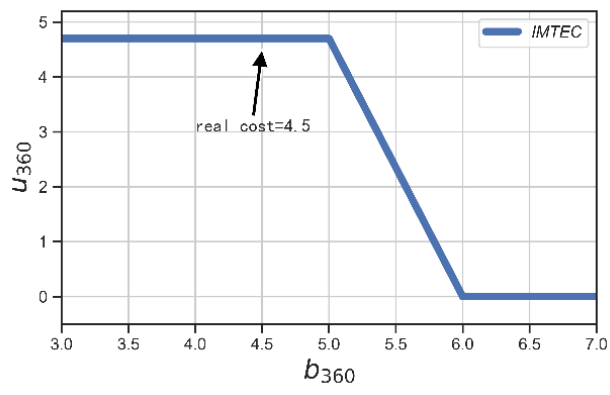
Figure 9. Utility of user with ID = 360 (winner).